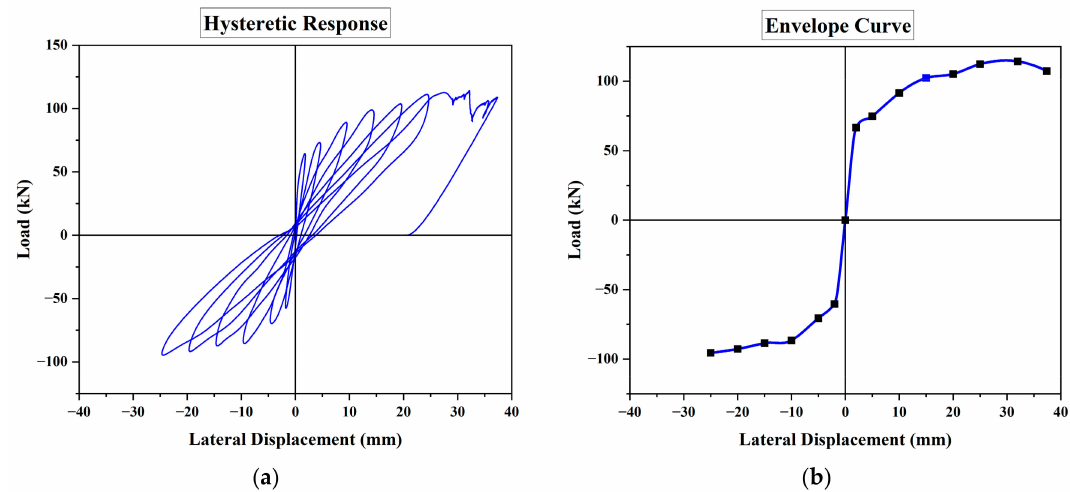
Figure 8. Experimental results of OPC-CM ( a ) Hysteretic response ( b ) Envelope curve. The hysteretic behavior of the GPC-CM test specimen exhibited slight irregular and asymmetric loops in the push and pull cyclic loads as shown in (Figure 9). The wall speci- men showed almost symmetric loops until the onset of bed joint cracks in the second loop of lateral load, after which the structural behavior of the wall shifted to an elastoplastic state and the wall stiffness steadily degenerated owing to the development and concentration of more and more cracks in the masonry pier. As with the cement concrete wall, the GPC wall also showed increasing seismic load capacity in each cycle reaching a maximum value of 119.10 kN at the drift of 2.32% in the last push load, after which the wall stopped taking further load and the lateral load carrying capacity of GPC-CM started decreasing and a sud- den drop in lateral strength was observed, at which point the test was terminated to avoid any accident or damage to the equipment attached to the wall. The initial stiffness (K C0 ) and the development of the shear stress in the masonry pier (V max /A w ) were estimated as 55.45 kN/mm and 0.66 MPa, respectively.